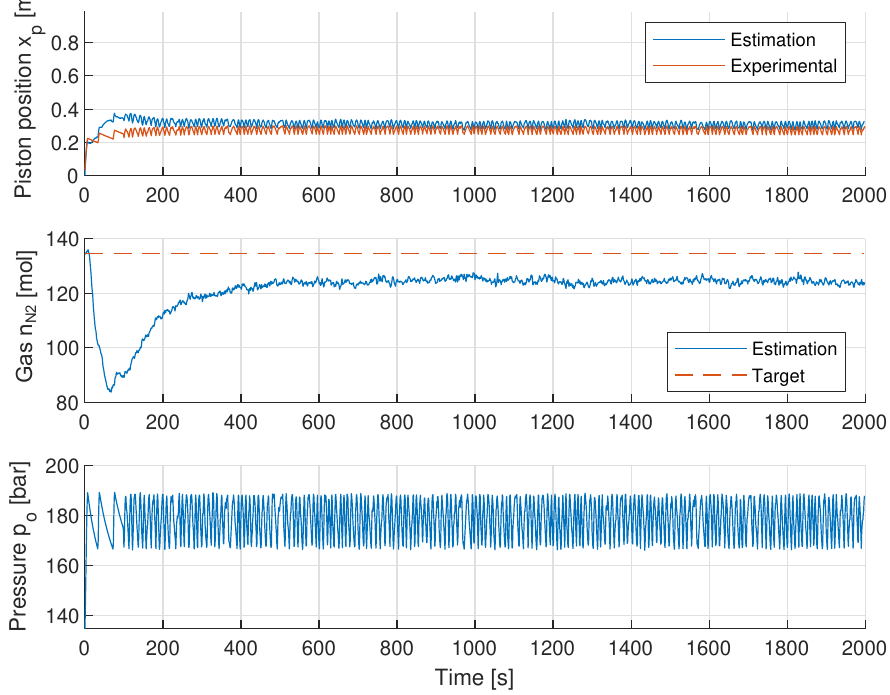
Figure 10. Estimated and experimentally measured piston position and estimated molar value of gas for the high-load test sequence. The accumulator is pre-charged to 125 bar/134